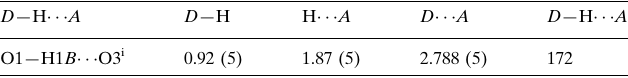
Hydrogen-bond geometry (A˚ , (cid:1)